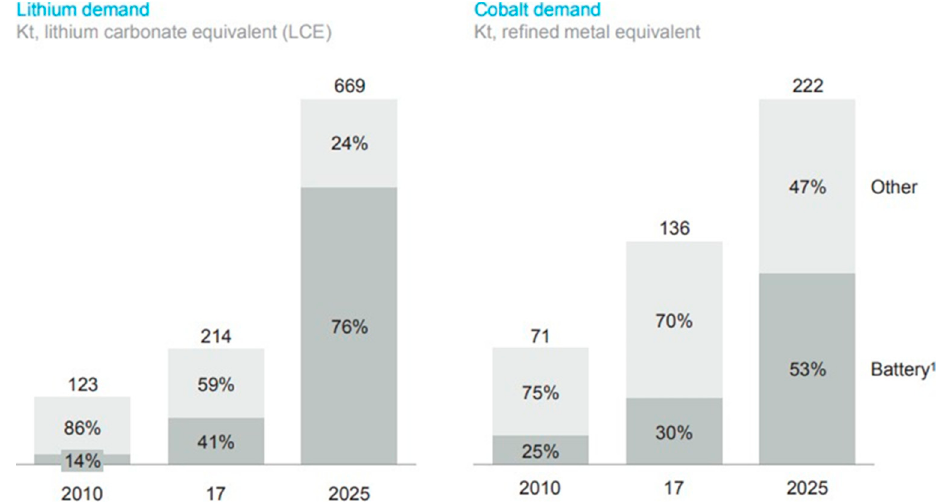
Figure 1. Lithium and cobalt demand the evolution of the whole market. Reproduced from [30].